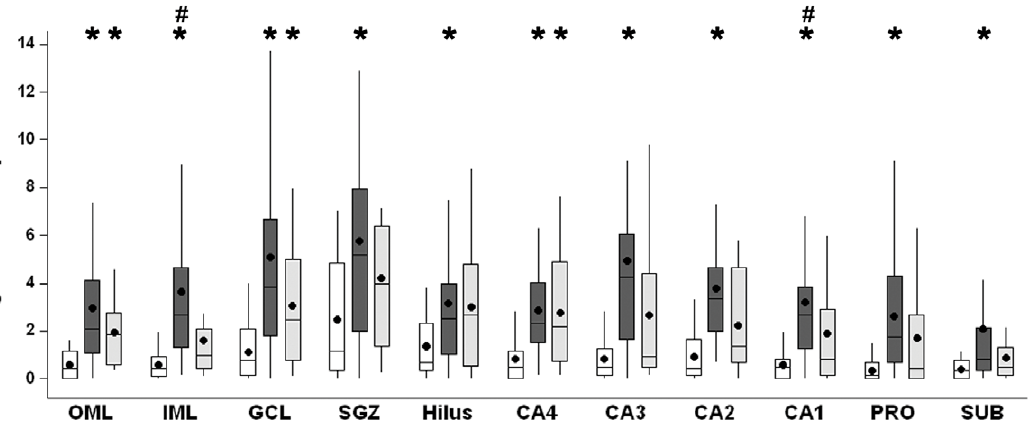
Figure 6. HLA-DR immunopositive area in hippocampal subfields of Ctrl, MTLE and TLE-TD groups. Compared to Ctrl (white boxplots), TLE groups had increased HLA-DR immunoreactivity (showed as percentage of immunopositive area) in outer molecular layer (OML), granule cell layer (GCL), CA4, and CA1 subfields (p , 0.001). MTLE (dark gray boxplots) had increased HLA-DR immunoreactivity in inner molecular layer (IML), subgranule zone (SGZ), hilus, CA3, CA2, prosubiculum (PRO) and subiculum (SUB) (p , 0.01). In IML, MTLE also presented increased HLA-DR immunoreactivity when compared to TLE-TD (p , 0.001). The * indicate difference from Ctrl and # difference from TLE-TD.